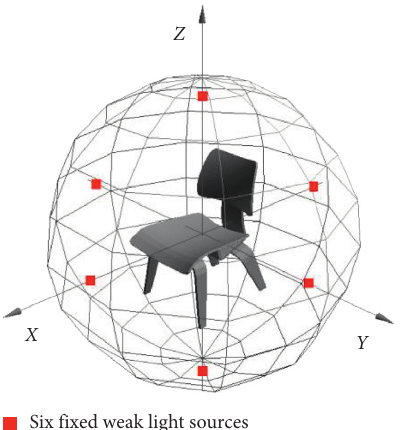
Figure 4: Placements of six fixed weak light